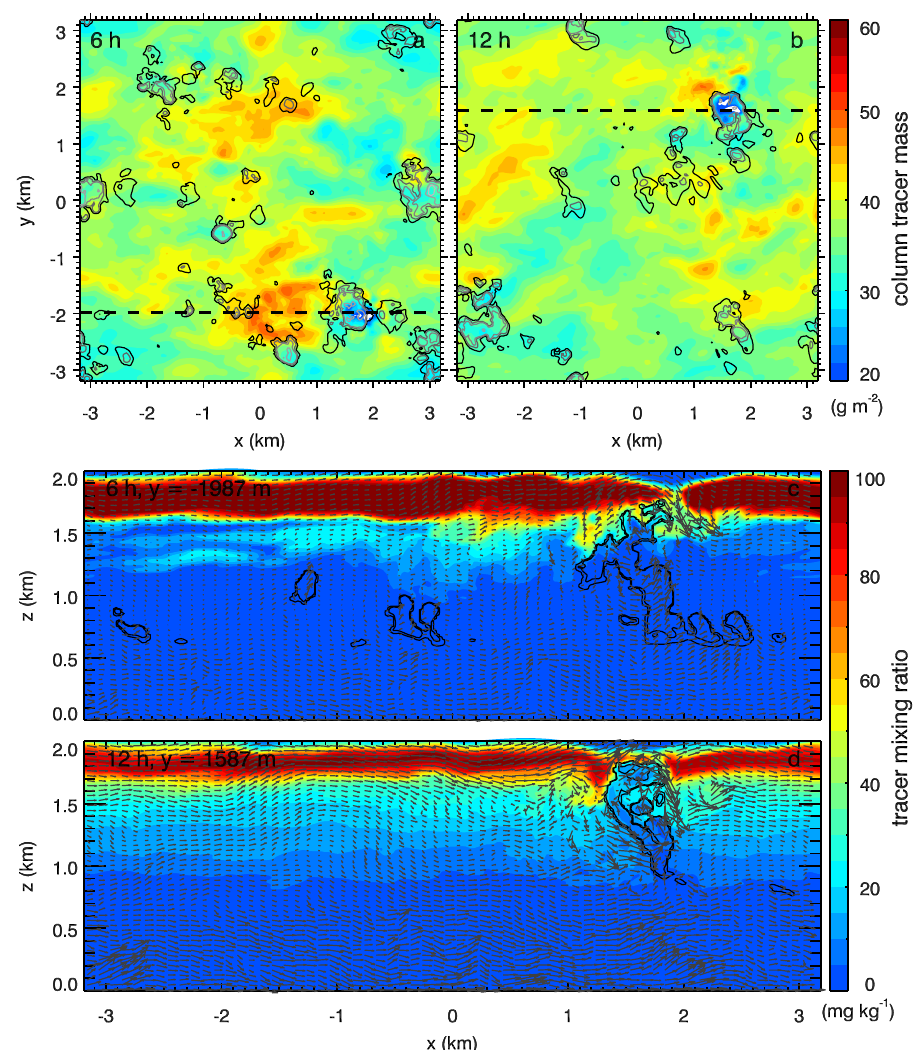
Fig. 6. As in Fig. 3, but for case 2. In (a) and (b) , cloud columns usually have lower tracer mixing ratio. Panels (c) and (d) confirm this, and show that cloud-free grids are responsible for downward transport, which mainly occurs in thin regions around clouds, indicating that the downward transport is also induced by cumulus